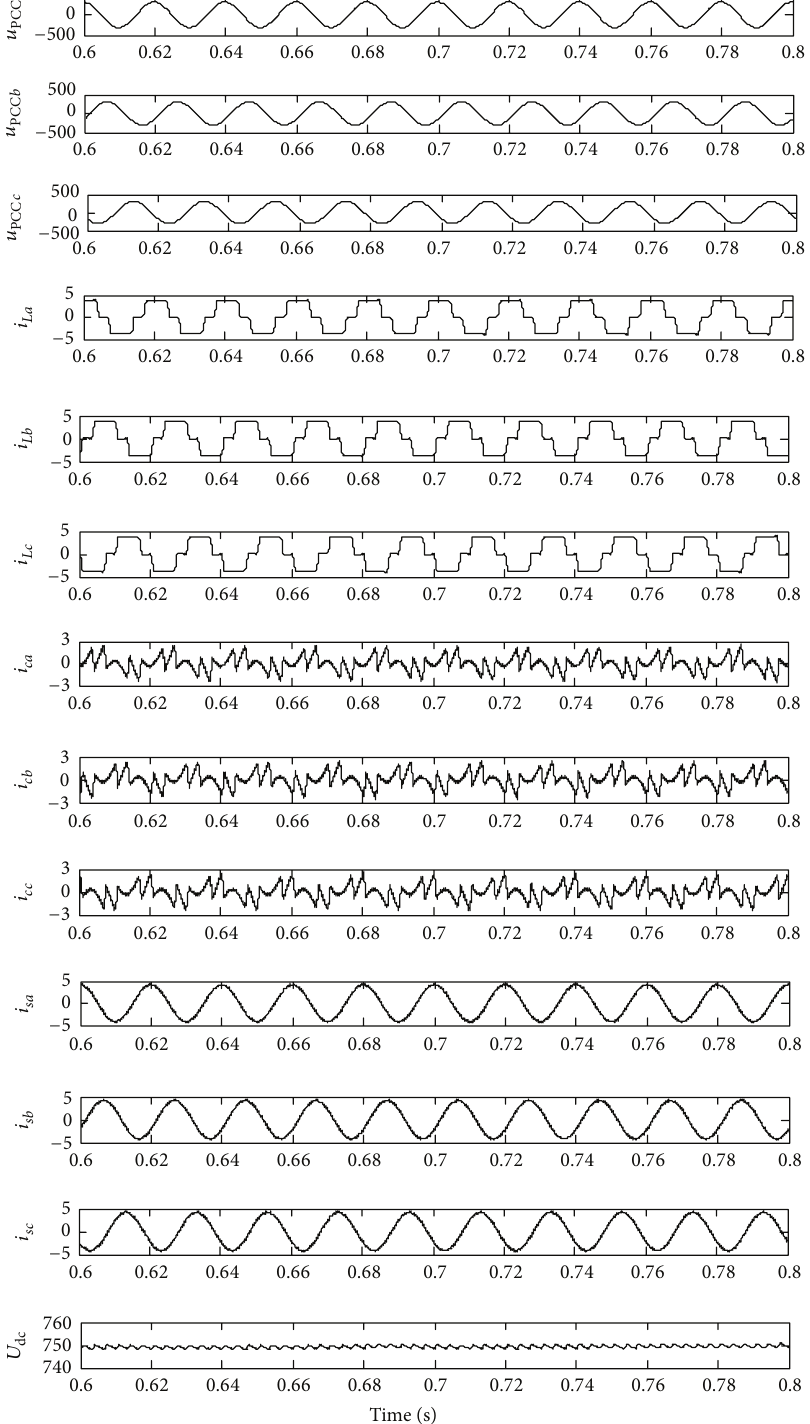
Figure 25: The simulation results using predictive current control designed by